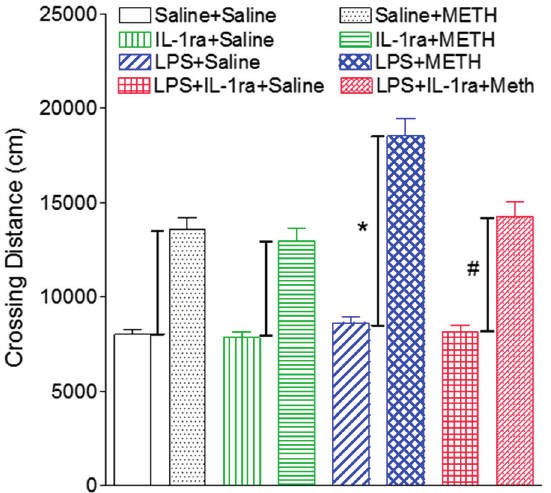
Figure 6. IL-1ra significantly attenuated enhanced locomotor activity (total distance traveled) upon METH challenge in P70 rats following neonatal LPS exposure. The results are expressed as the mean ± SEM of six animals in each group and analyzed by two-way ANOVA. * p < 0.05 represents significant difference between the increment in METH-increased locomotor activity within the LPS group ( ∆ (LPS+METH – LPS+Saline) ) as compared to that within the saline group ( ∆ (Saline+METH − Saline+Saline) ). # p < 0.05 represents significant difference between the increment in METH-increased locomotor activity within the LPS+IL-1ra group ( ∆ (LPS-IL-1ra+METH − LPS-IL-1ra+Saline) ) as compared to that within the LPS group ( ∆ (LPS+METH − LPS+Saline)